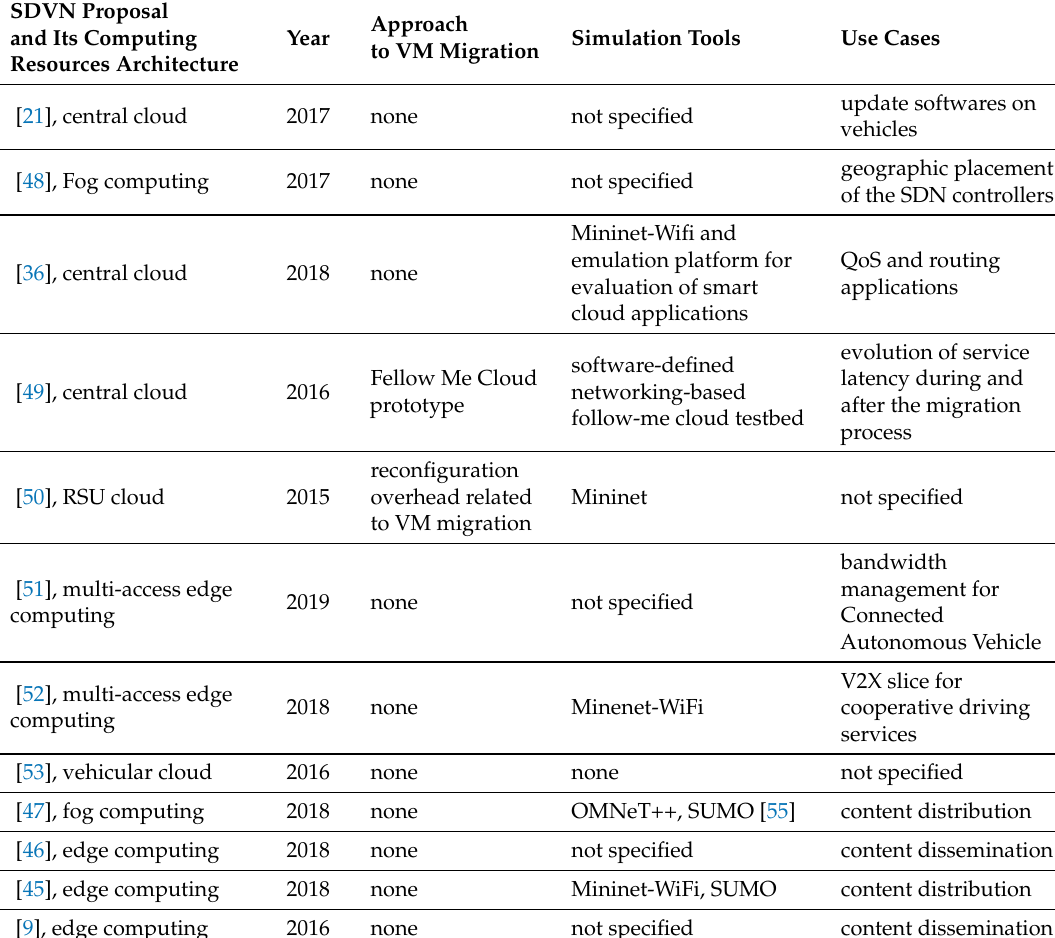
Table 2. Review of the state-of-the-art of VM migration techniques over